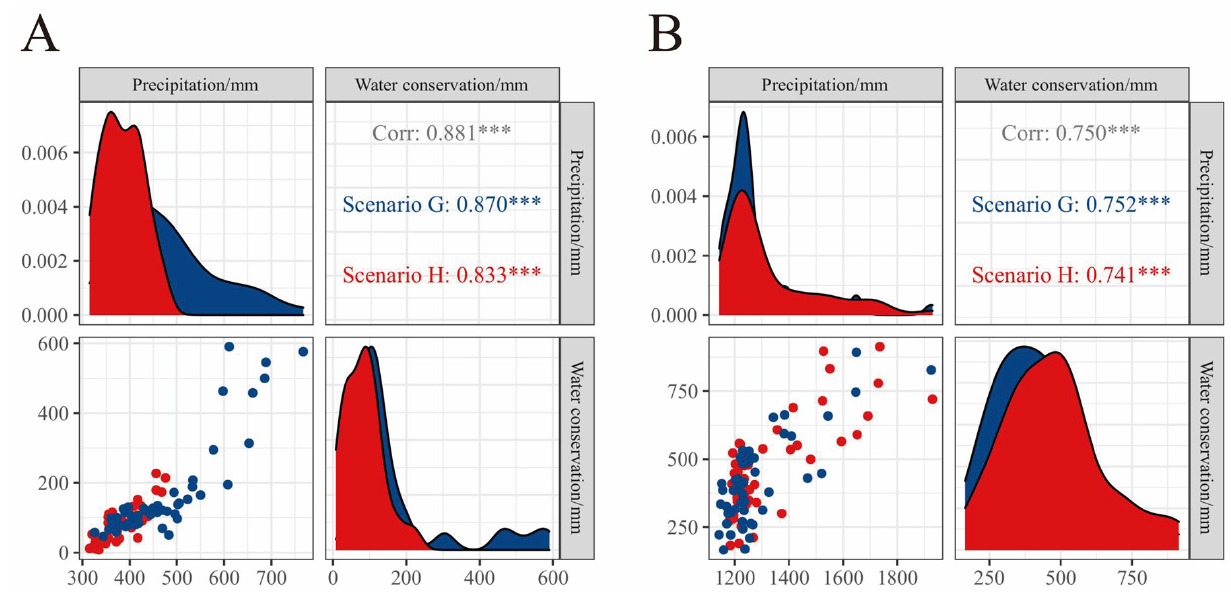
Figure 4. An analysis of rainfall and WCA for scenarios H and G for the watershed. ( A ) Dry season; ( B ) wet season. Note: *** indicates significance at the α = 0.001 level.